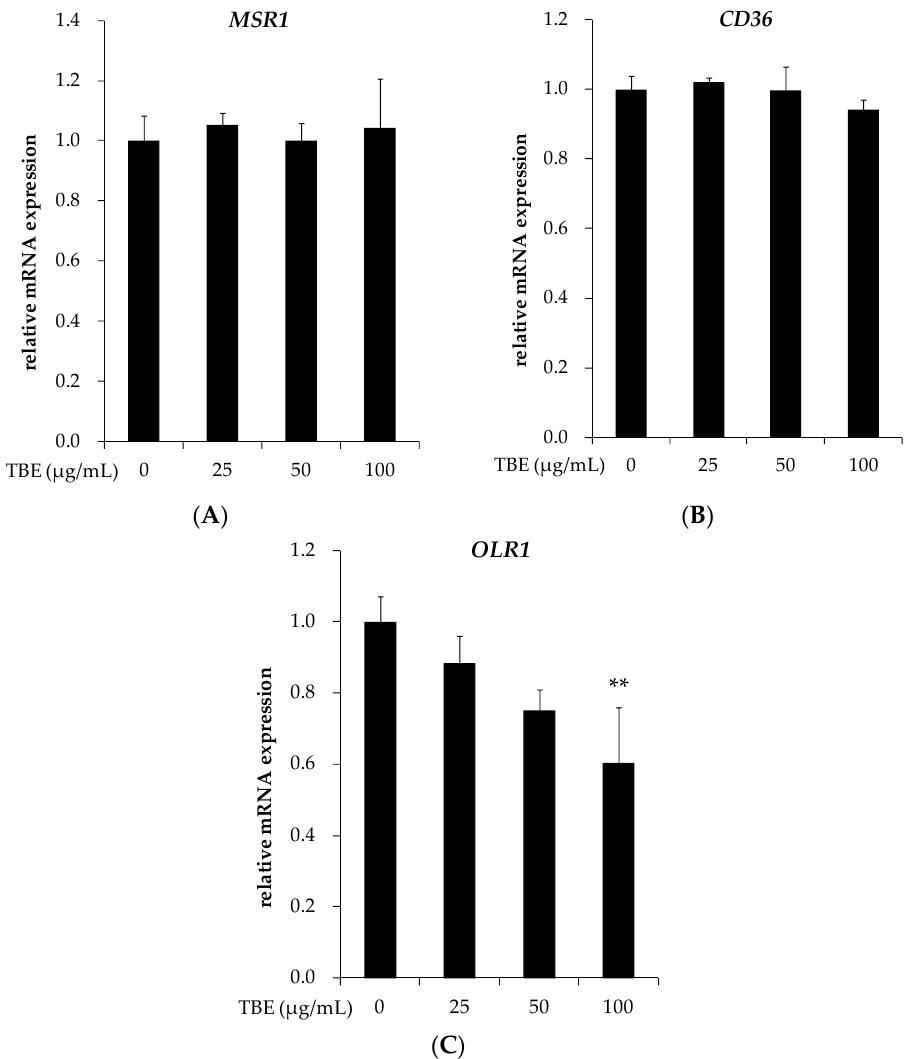
Figure 5. Effect of TBE on the mRNA expression of scavenger receptors in macrophages. THP-1 macrophages were incubated with 25–100 μ g/mL TBE for 24 h. MSR1 ( A ), CD36 ( B ) and OLR1 ( C ) mRNA expressions were measured by real-time RT-PCR. Values are means ± SD ( n = 3). ** p < 0.01, compared to untreated control group.